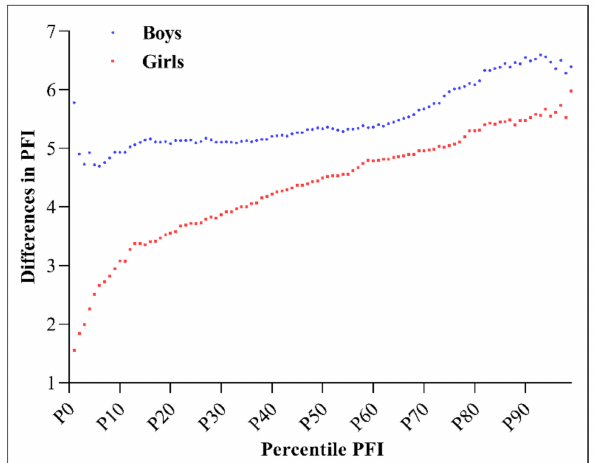
Figure 3. Physical fitness index (PFI) di ff erences between China and Japan for each gender across PFI percentiles.